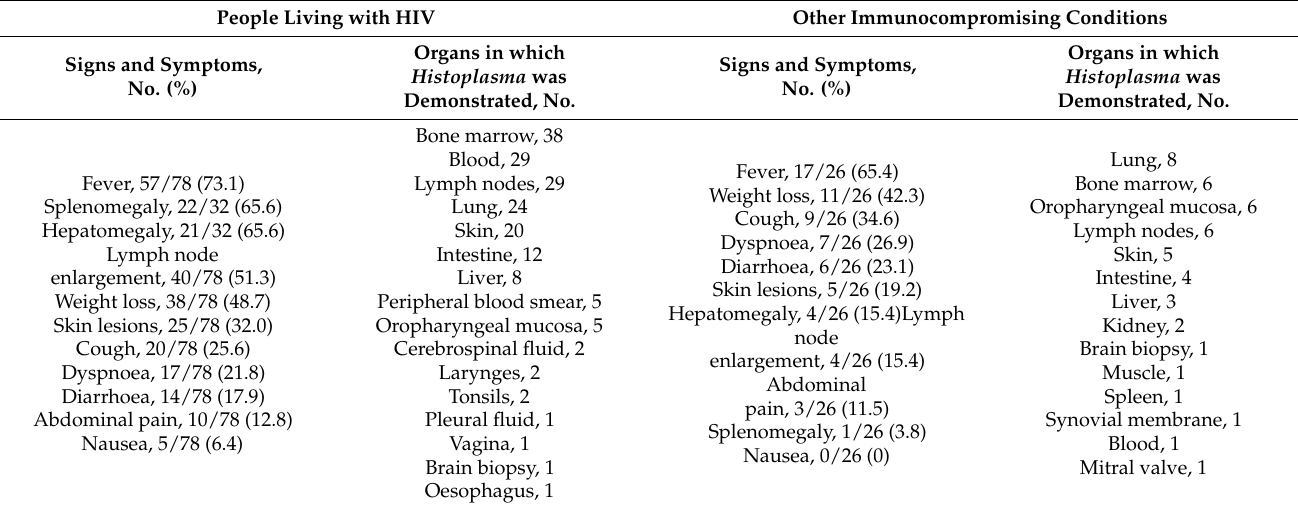
Table 3. Summary of the signs and symptoms of histoplasmosis in people living with HIV or other immunocompromising conditions, and the organs in which Histoplasma spp. was demonstrated. People Living with HIV Other Immunocompromising Conditions Organs in which Organs in which Signs and Symptoms, Signs and Symptoms, Histoplasma was Histoplasma was No. (%) No. (%) Demonstrated, No. Demonstrated,